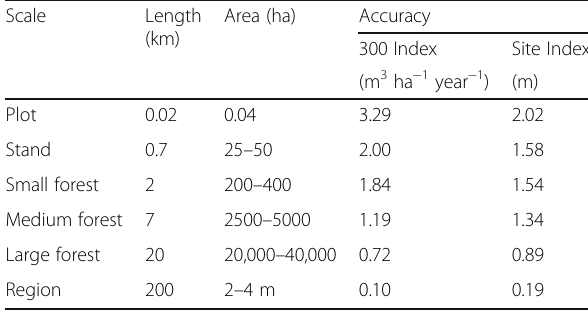
Table 3 Prediction accuracy (equivalent to RMSE) of 300 Index and Site Index for a range of spatial